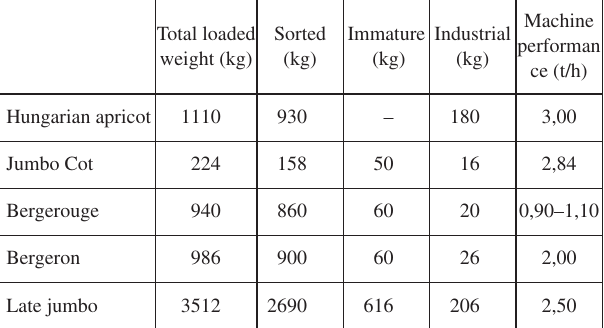
Table 6. Some operating characteristics connected to